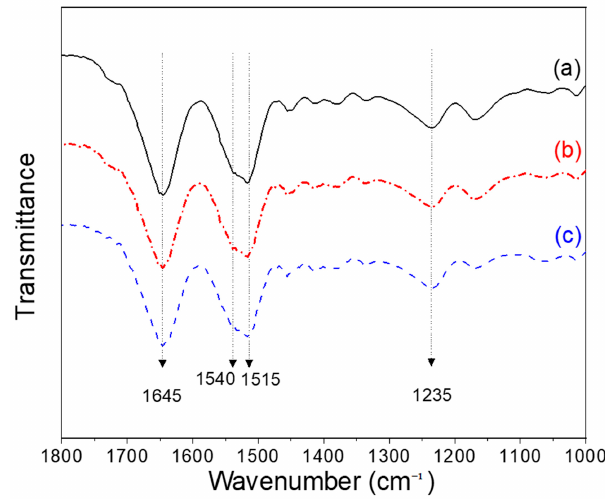
Figure 5. Effect of relative humidity on the Fourier transform infrared spectra of the electrospun regenerated silk web. Silk concentration was 17.5% at ( a ) 20%, ( b ) 40%, and ( c ) 60% relative humid- ity. In the amide, I band, an absorption peak appeared at 1645 cm − 1 . Two peaks, at 1515 and 1540 cm − 1 , are overlapped in the amide II band and a peak at 1235 cm − 1 is shown in the amide III bands. The infrared (IR) absorption peaks at 1645, 1540, and 1235 cm − 1 are attributed to the random coil conformation of the silk. On the other hand, the peak at 1515 cm − 1 corresponds to β -sheet conformation [61–66]. This result showed that the electrospun silk web simultaneously has a random coil and β -sheet conformations. This result is con- sistent with that of silk web electrospun from silk formic acid dope solution [24–26]. As reported in a previous study, the partial β -sheet crystallization in the electrospun web from silk formic acid is due to (1) short flight time of polymer jet and (2) crystallization- inducing formic acid, i.e., formic acid induces crystallization of silk when the formic acid is eliminated from the silk [67]. However, the crystallization of silk is restricted because the silk molecules have insufficient time to be arranged. Finally, the silk is partially crys-